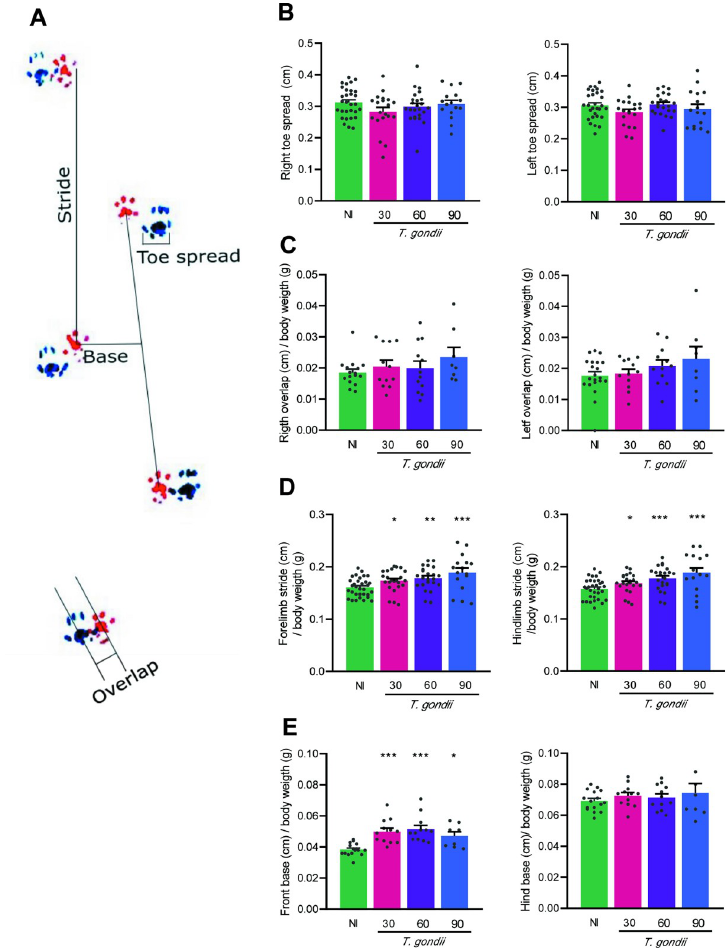
Fig 3. Mice with long-term chronic Toxoplasma gondii infection show preserved locomotor capacity. ( A ) The gait analysis was performed using the footprint test and were evaluated as such: the spread of the fingers and overlapping distance between the anterior and posterior limbs, right and left, and the stride length of limbs, width of the front and rear base. ( B ) The toe spread was normal in the right and left limb. ( C ) |No alteration was observed in the right and left step overlap of infected mice. ( D ) The forelimb and hindlimb stride were increased as the infection progresses. ( E ) The width of the front base was enlarged in infected mice, but the hind base was preserved. Each experimental group consisted of 4–6 NI mice and 8–12 T . gondii-i nfected mice. Each circle represents an individual mouse. Data are expressed as means ± SEM, and were analyzed using ordinary one-way ANOVA. � , p < 0,05, �� , p < 0.01. ��� , p < 0.001, comparing T . gondii- infected and NI